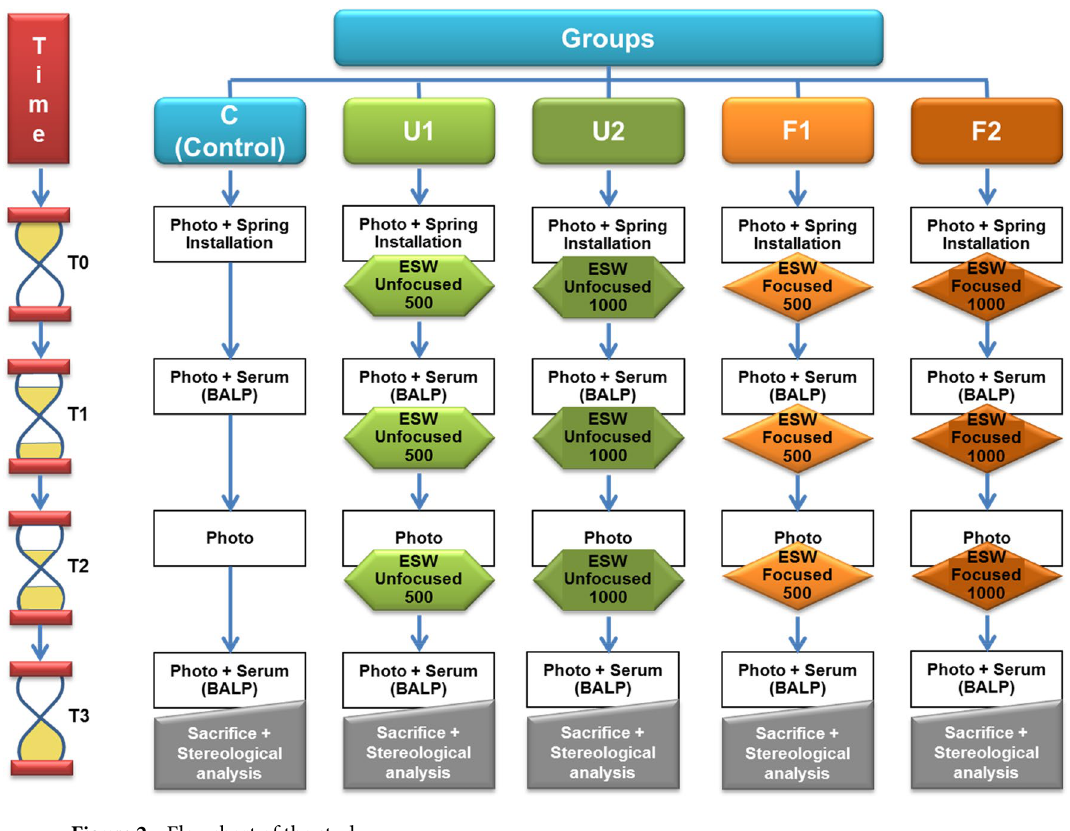
Figure 2. Flowchart of the